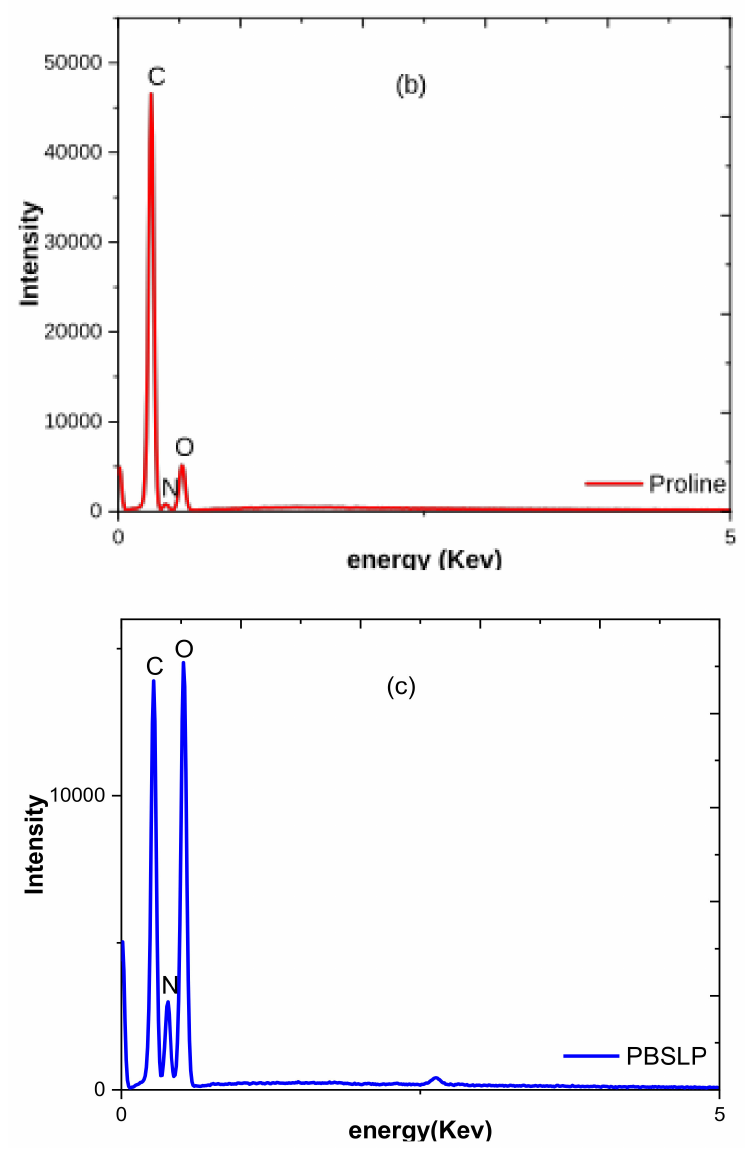
Figure 6. Energy dispersive X-ray (EDX) graphs showing the excitation of di ff erent elements within ( a ) PBS, ( b ) L-proline, and ( c )